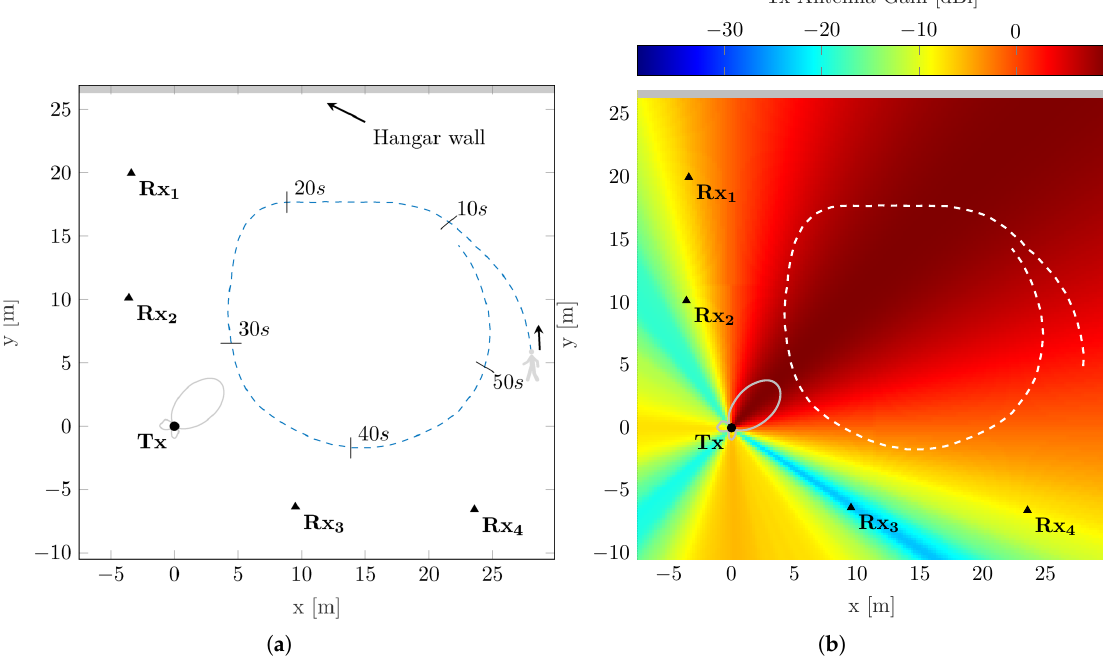
Figure 1. Overview of the evaluated measurement network with transmitting and receiving nodes as circle and triangles. The dashed lines illustrate the trajectory traveled. The gray line highlights the hangar wall as the strongest static reflector in the environment. The vertical radiation pattern of Tx antenna is shown in light gray. ( a ) Scenario overview with starting position of moving pedestrian and movement direction; ( b ) Scenario overview illustrating gain of small directional transmit antenna [28].